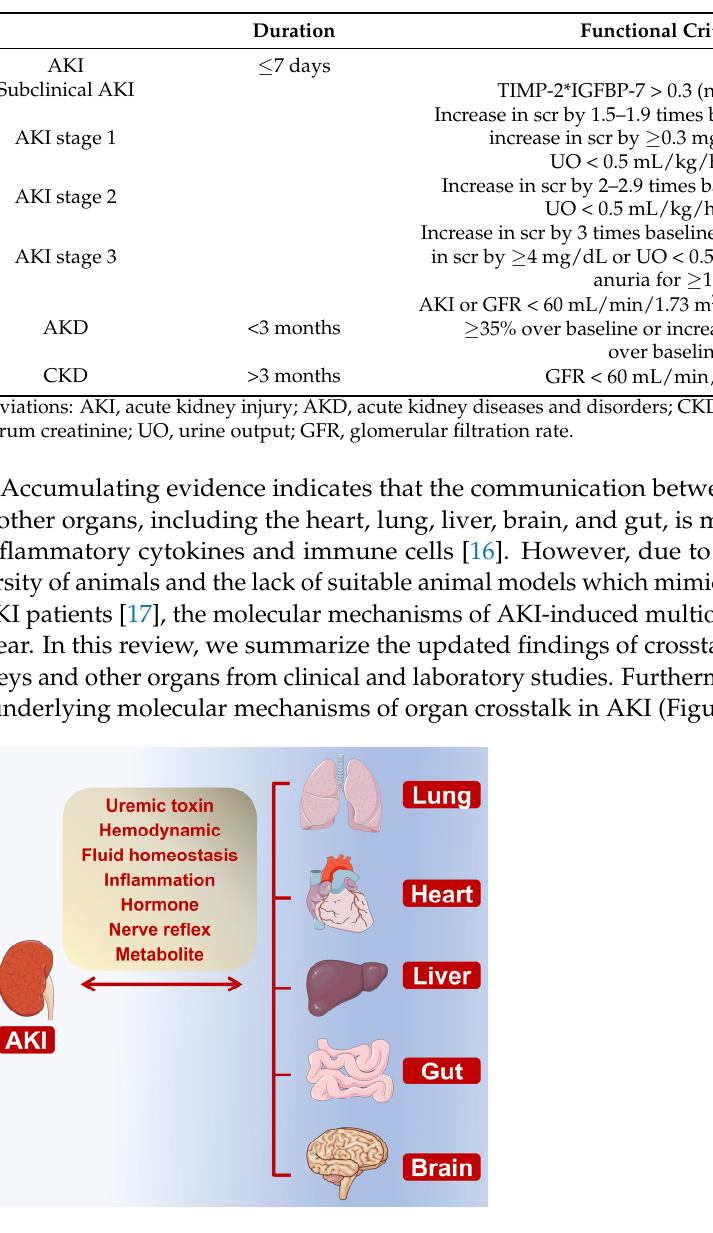
Table 1. Classification and criteria of AKI, AKD, and CKD.